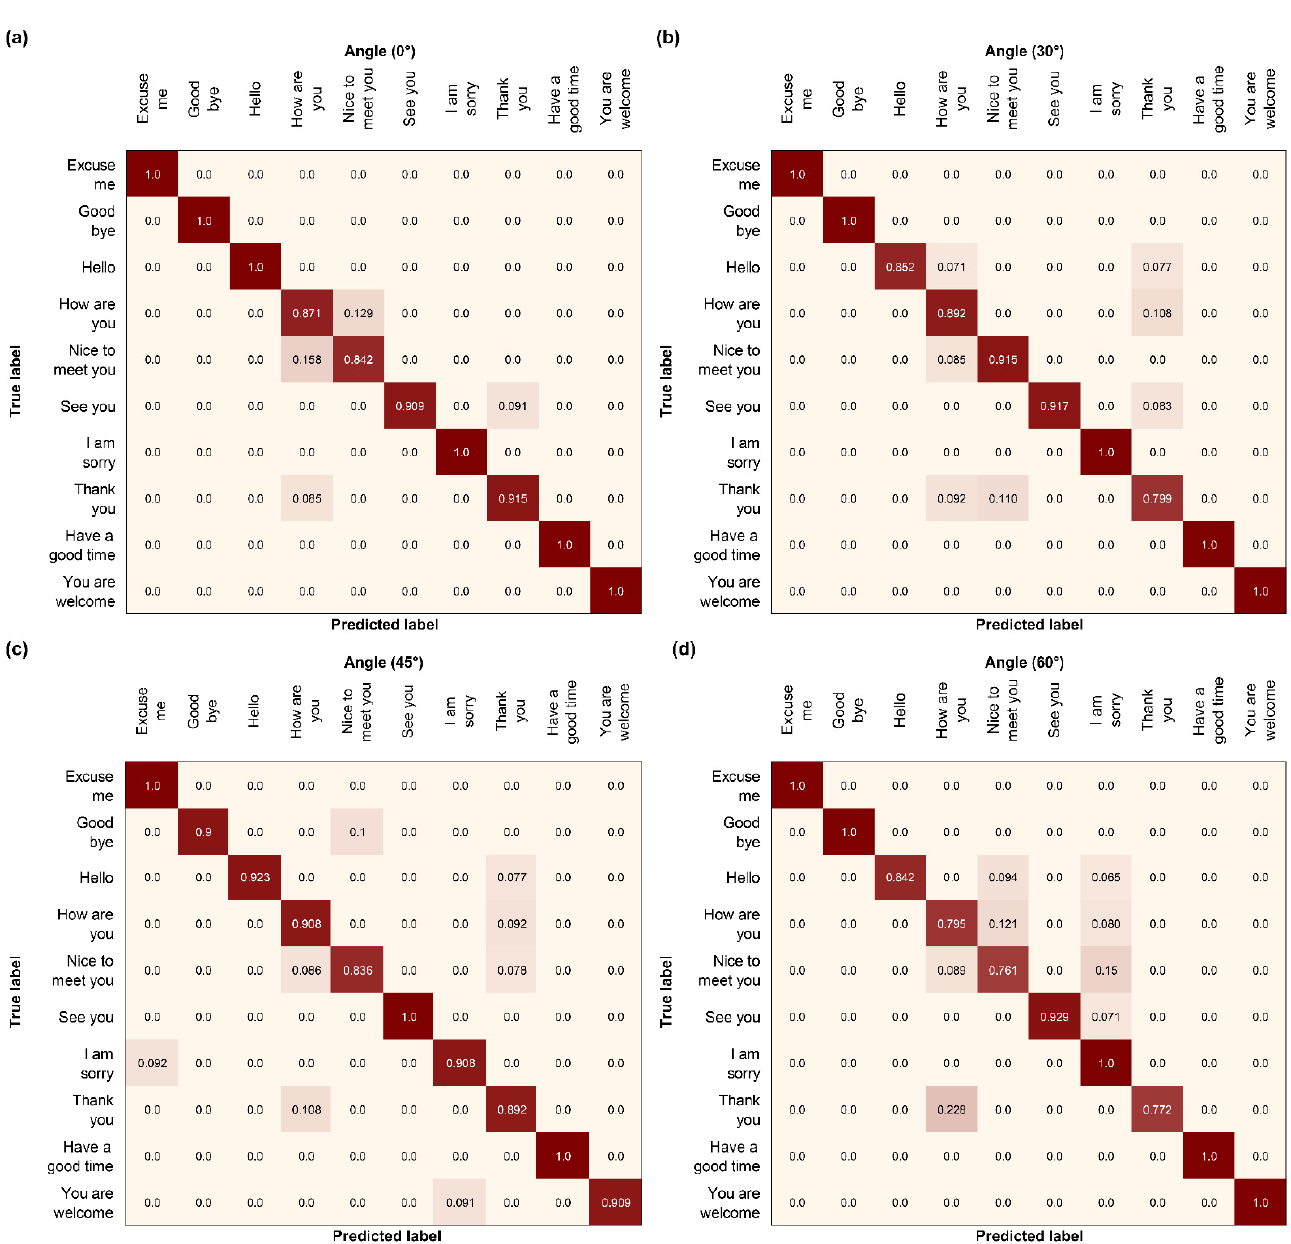
Figure 13. Comparison of confusion matrix models: ( a – d ) Model H.